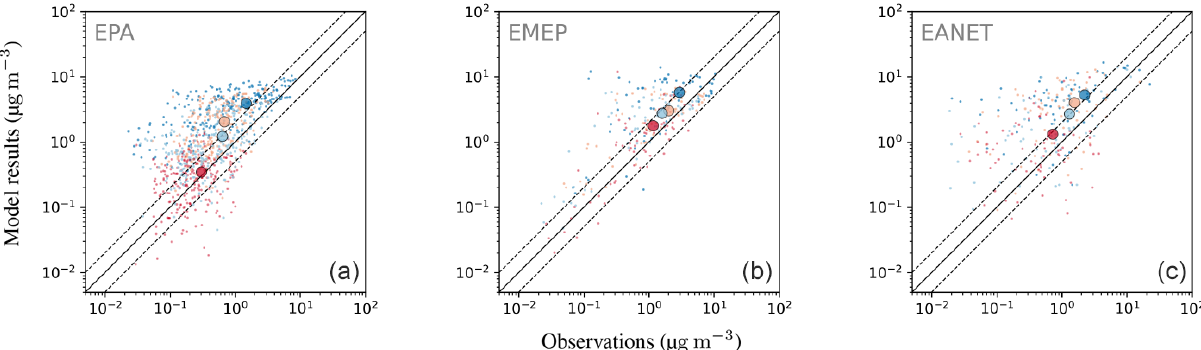
Figure 23. The same as Fig. 20 but for NO −